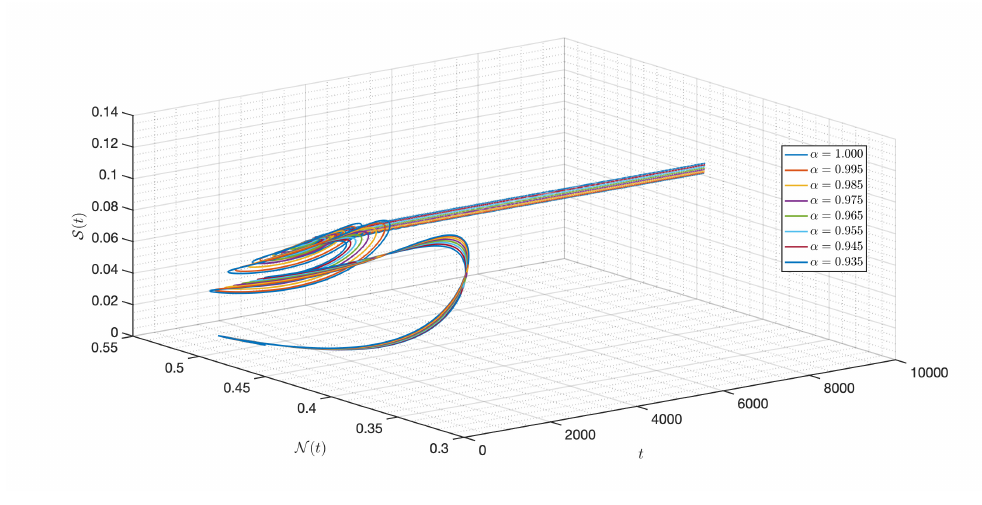
Figure 29. Dynamic of the model (3) for different parameters in Case III .